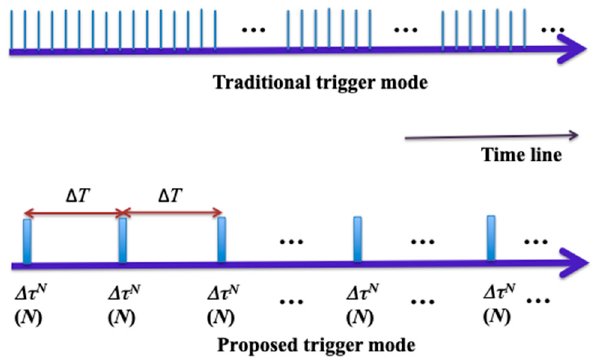
Figure 3. Traditional trigger configuration (TTC) versus proposed trigger configuration (PTC), where each blue bar represents detection time when scanning one location. Symbol ∆ τ N ( N ) denotes taking N measurements within ∆ τ N .